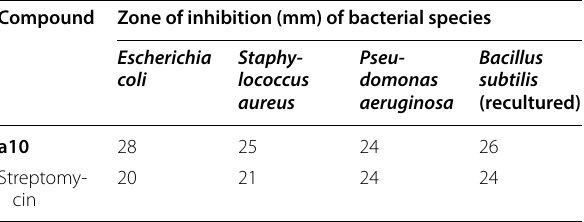
Table 5 Antibacterial activity data of compound a10 Compound Zone of inhibition (mm) of bacterial species